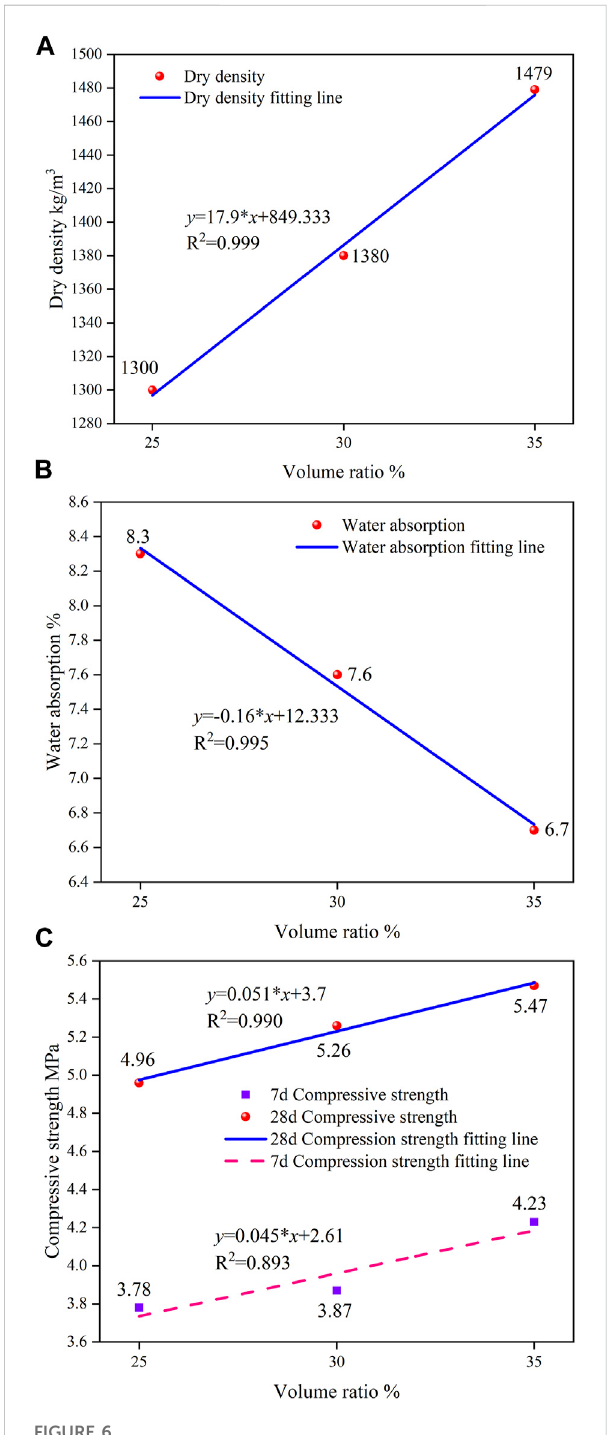
FIGURE 6 The in fl uence of RCA volume fraction on sample performances: (A) dry density; (B) water absorption; (C) compressive